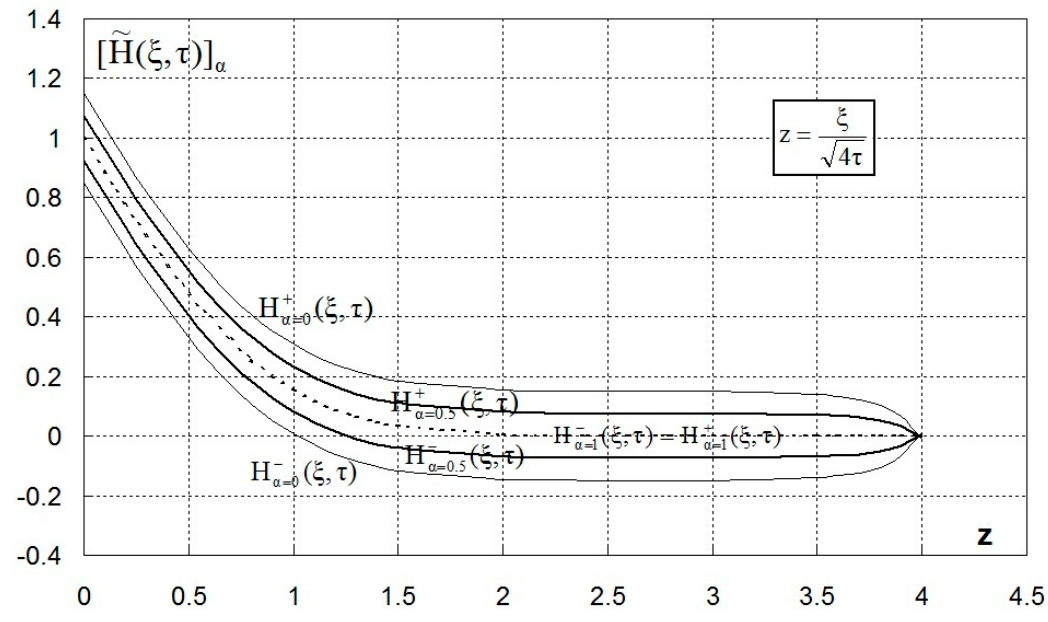
Figure 6. Variation of α